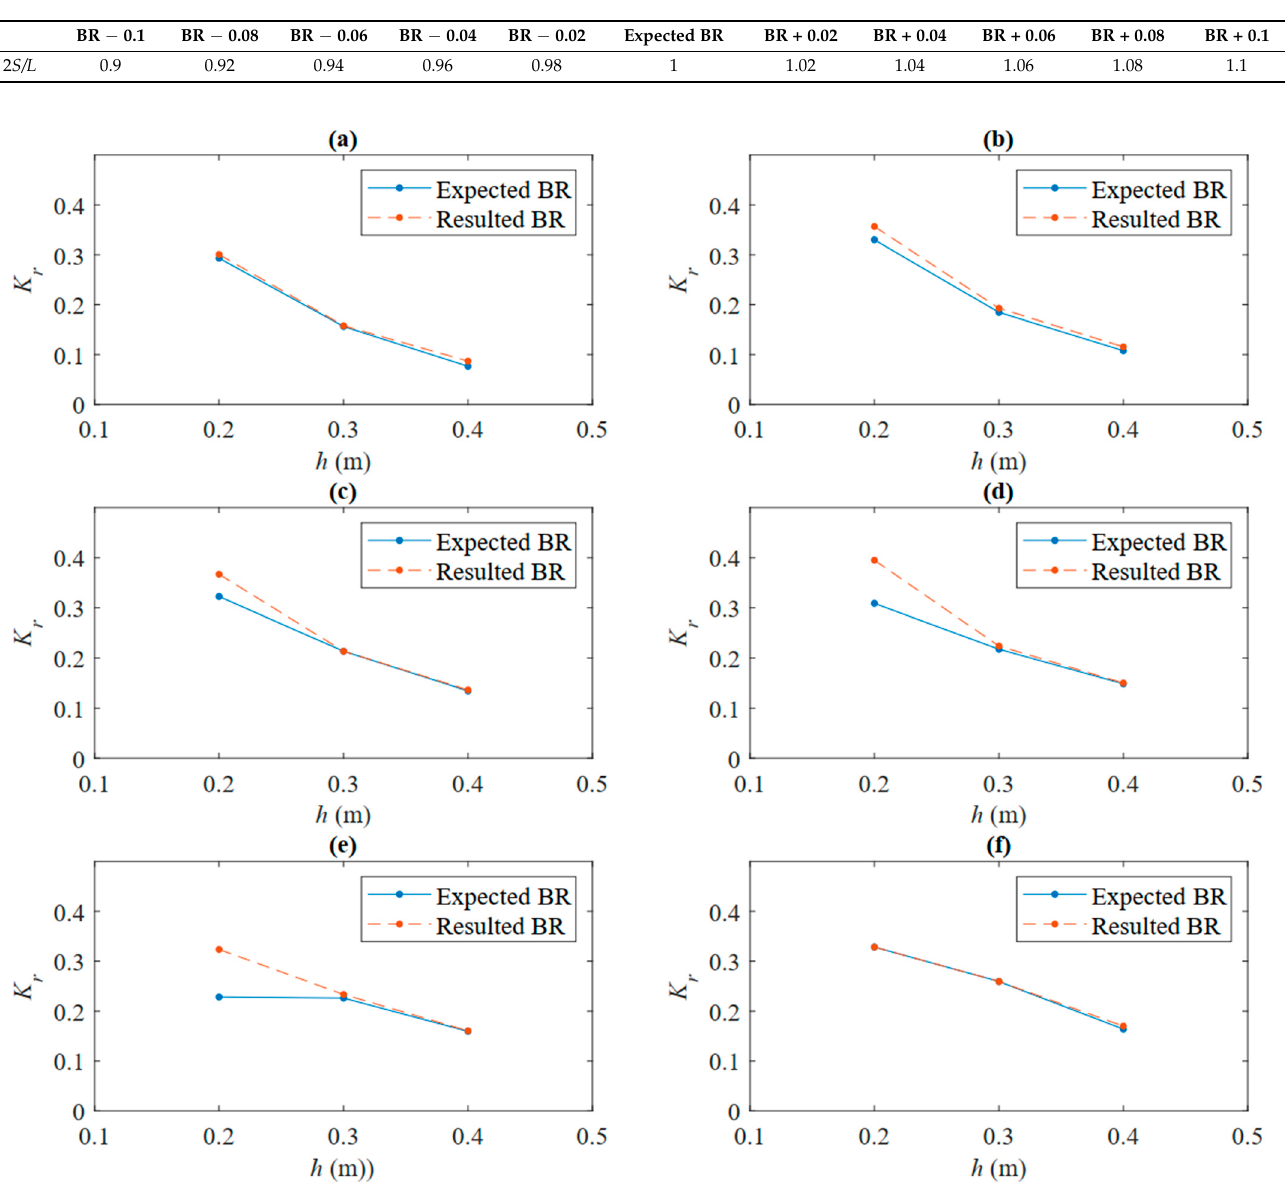
Table 2. Data sampling of the expected BR and ± 1 in 2S/L .